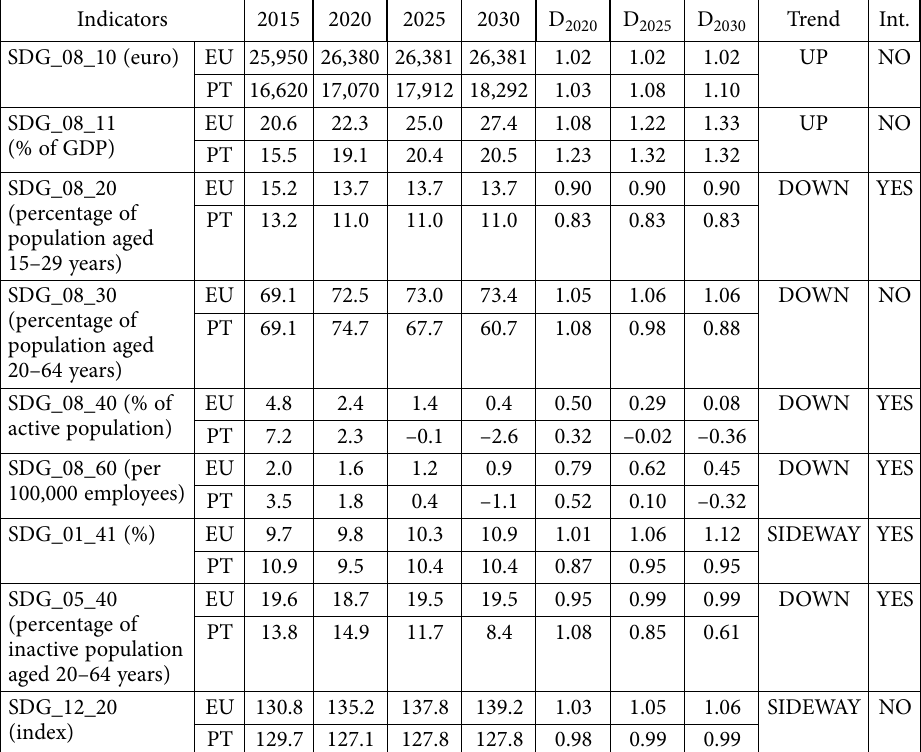
Table 9. SDG 8 – Decent work and economic